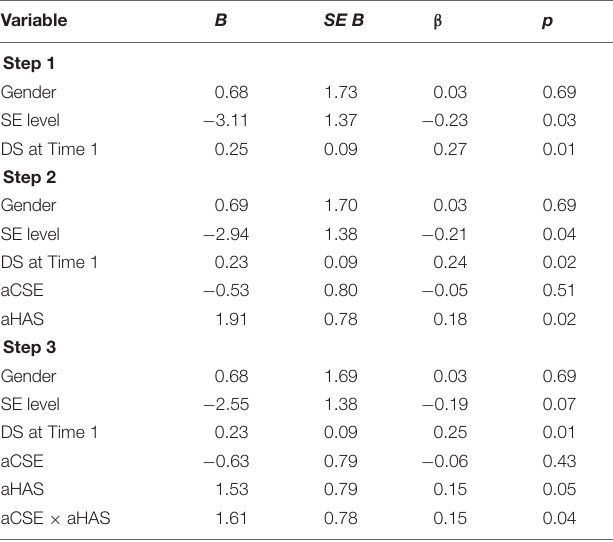
TABLE 5 | Statistics from regression analyses predicting DS at Time 2.